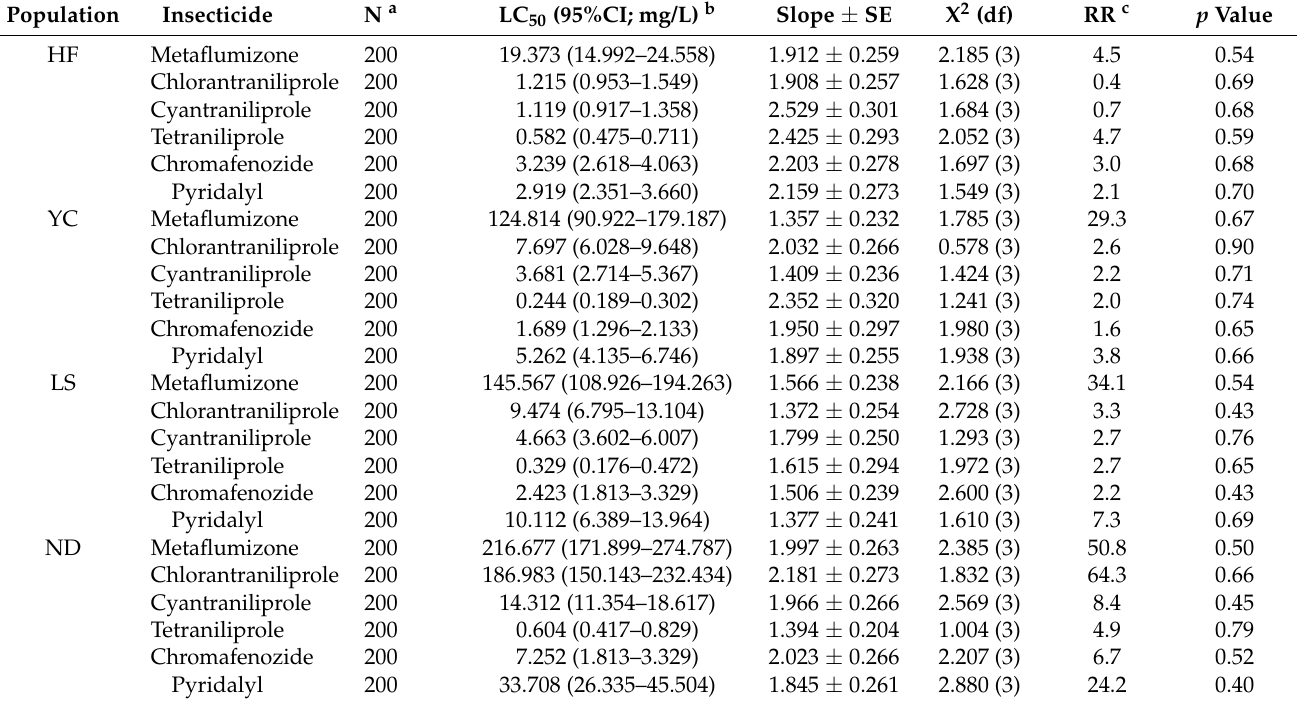
Table 5. Insecticide susceptibility of S. litura collected from eastern China.